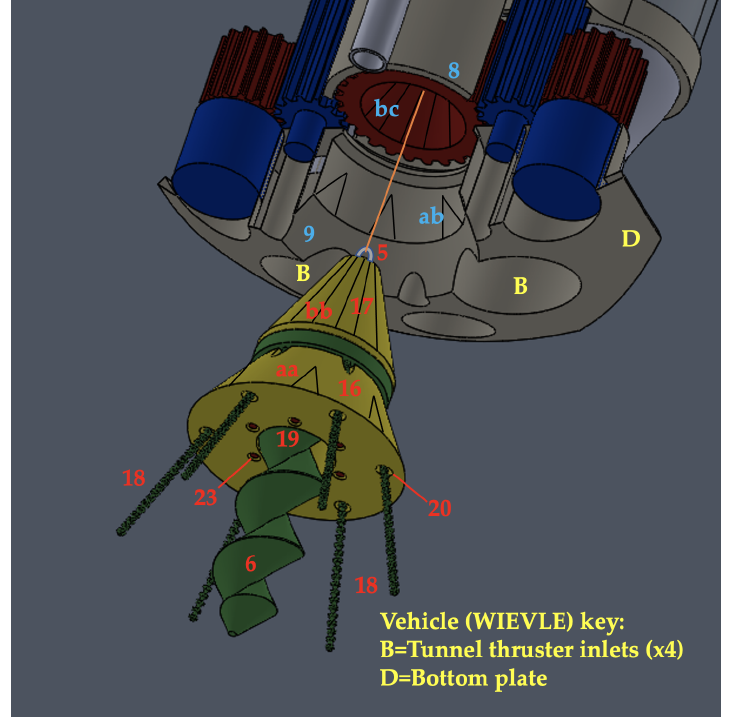
Figure 6. RAATM anchor assembly components in the tethered